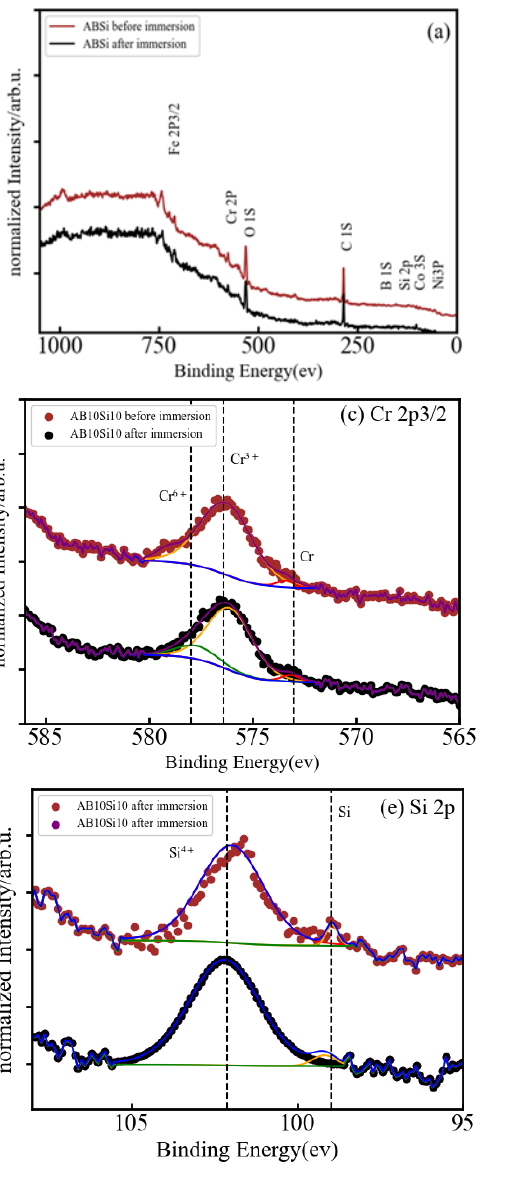
Figure 6. ( a ) Normalized XPS spectrum of AB10Si10 after immersion in 3 wt.% NaCl, and ( b – e ) high- resolution XPS spectra of Fe 2p3/2, Cr 2p3/2, O 1s, and Si 2p.